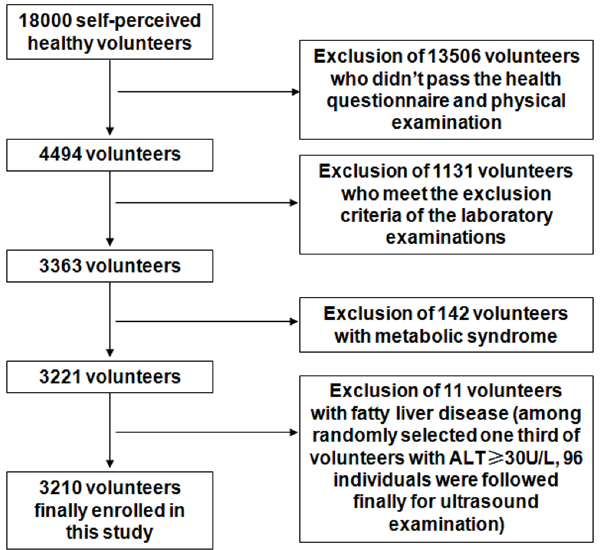
Figure 2. Procedures for selection of the study participants.